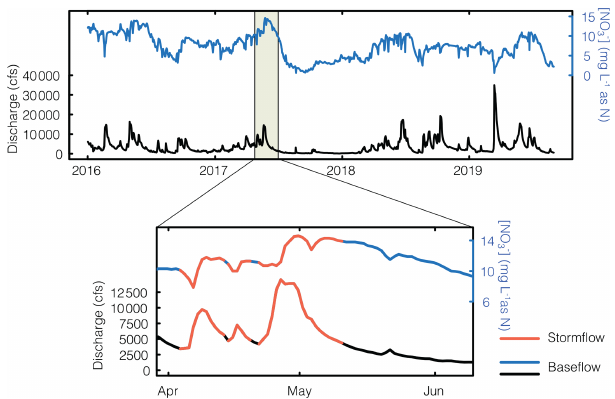
Figure 2. Example hydrograph and chemograph from one gaging station over the 4-year period of analysis, with the magnified portion showing stormflow periods (red) and baseflow periods (blue and black). For full records of all five watersheds, see Fig.